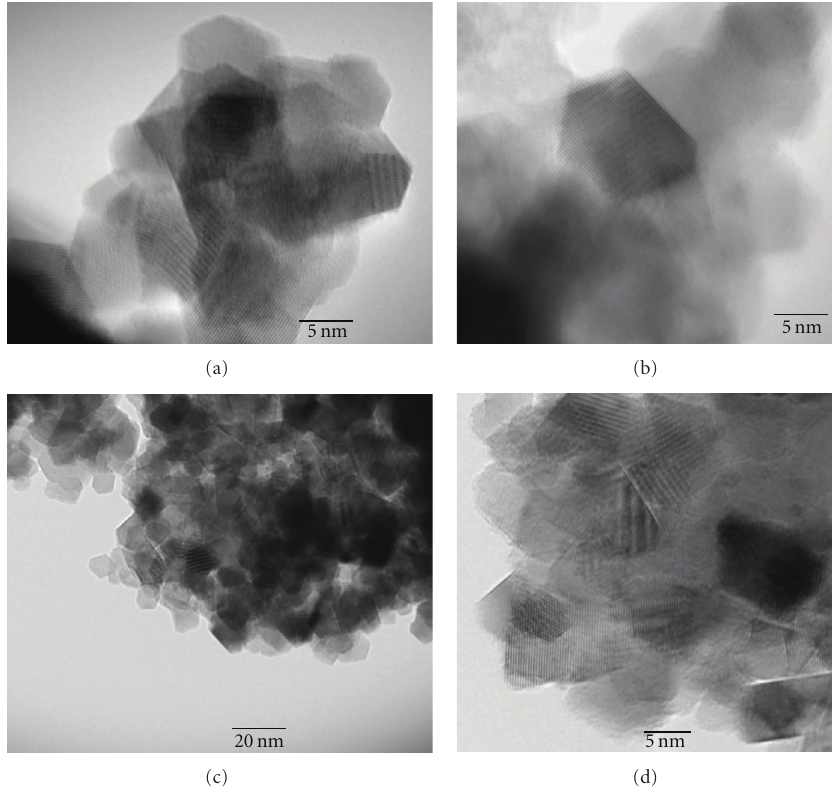
Figure 4: TEM images of the sulfided catalysts: (a) RPR333, (b) RPR322, (c) RPR232, and (d) RPR223.